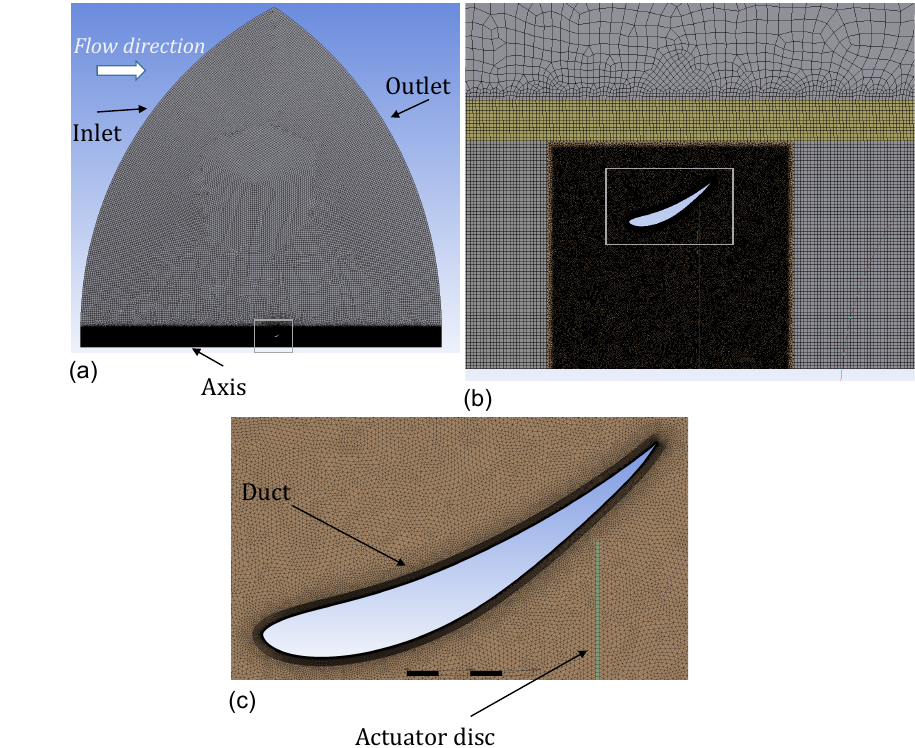
Figure 2. The domain and mesh (a) ; the zoomed-in view of mesh showing the structured mesh upstream and downstream of the duct (b) ; and the more-zoomed-in view of mesh showing the boundary layer mesh, the structured mesh of the actuator disc, and the unstructured triangular mesh between duct and the actuator